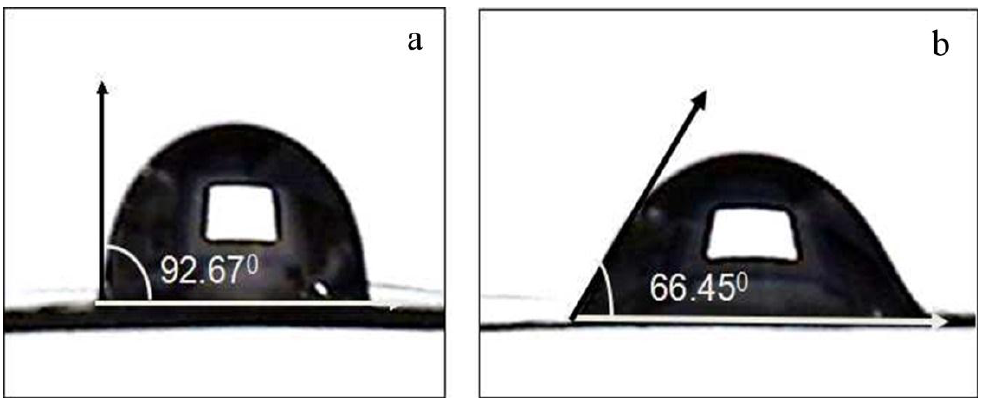
Figure 3. The image of contact angles on Raw-CF and CF-N h3 ( a ) Results and image of contact angles on Raw-CF; ( b ) Results and image of contact angles on Raw-CF.